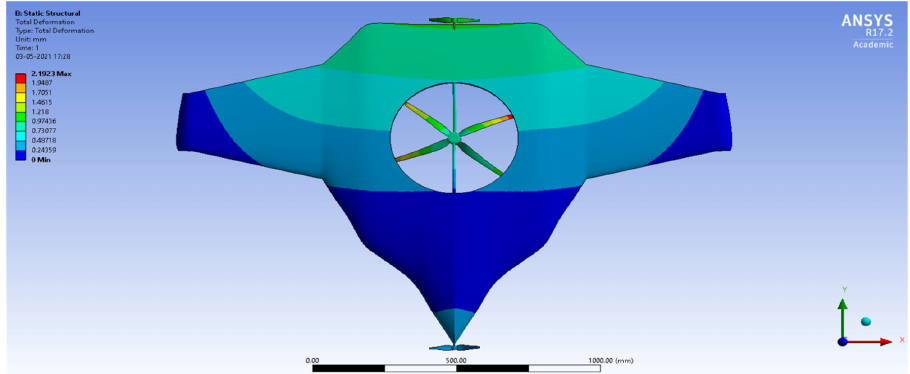
Figure 13. Equivalent stress.